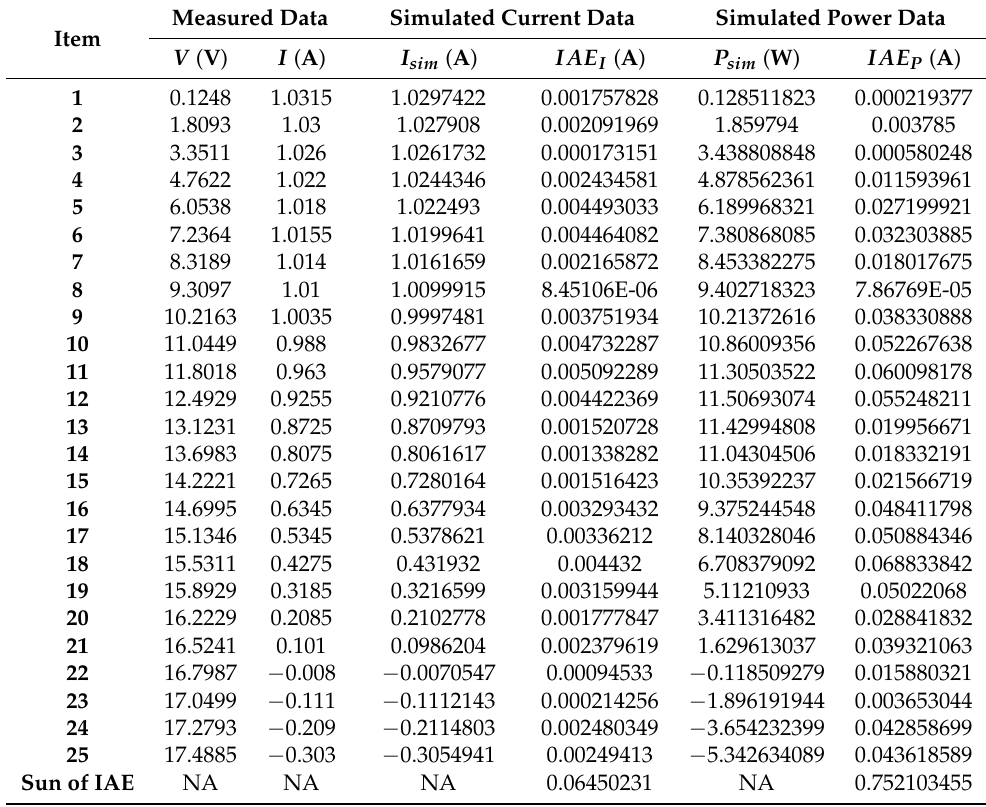
Figure 7. Error index of PV module (SDM) IAE values and RE values. Table 11. IAE of MLCPA on PV